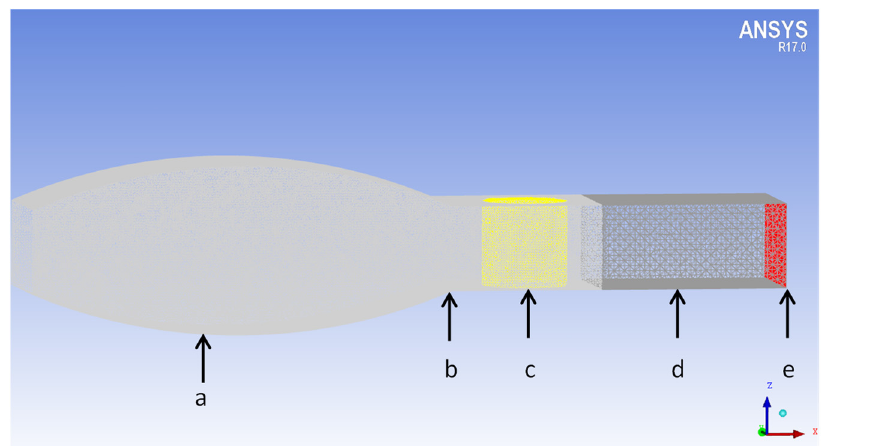
Figure 4. Geometries of the wind tunnel sections in 3D with coordinates: ( a ) the settling chamber section, ( b ) the inlet location, ( c ) the inner fluid where the wind model is located, ( d ) the test section and diffuser, and ( e ) the outlet section.